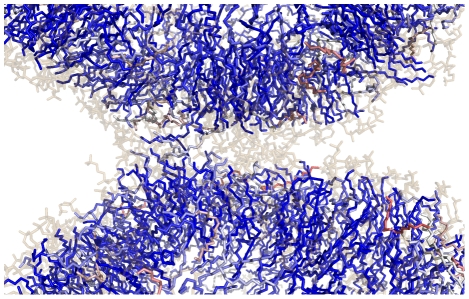
Orientation of lipid tails in a nascent fusion stalk.Most of the lipids near in this early stalk structure are either radially or tangentially aligned, not antiparallel. The stalk forms a hydrophobic “narrow bridge” between contacting vesicle outer leaflets, similar to that proposed by Kozlov and Markin[5], [12]. Outer leaflet lipids from both vesicles are shown in stick form with the lipid tails colored by the tail orientation relative to the vesicle radius. Tails aligned with the vesicle radius are colored dark blue, tails aligned antiparallel to the radius are colored dark red, and tails tangent to the vesicle are colored white. A few antiparallel tails can be seen in red, but these are generally far from the stalk. Head groups are shown in transparent brown.